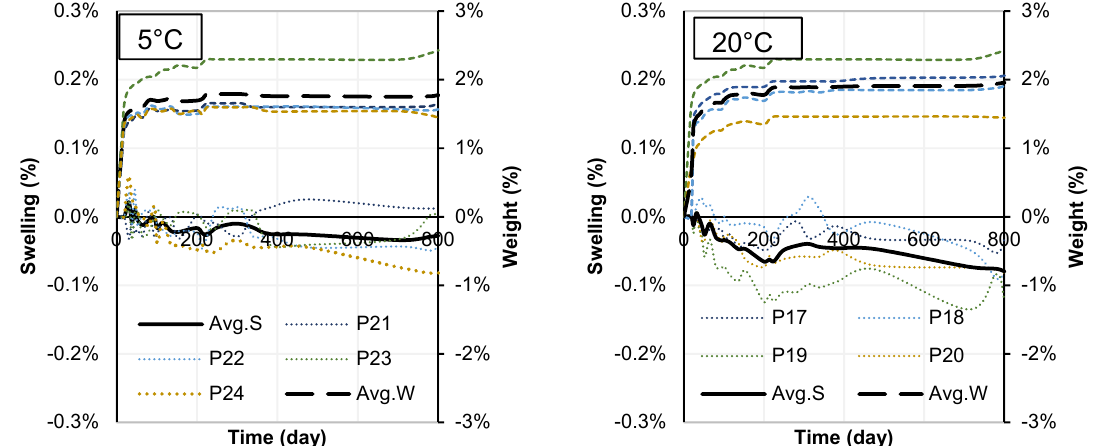
Figure A2. Swelling results in S + F + W3. The swelling and weight change in soil stabilized with cement and tap water are shown in Figure A3. The weight change in the sample at 20 °C was 1.23%, and the swelling/shrinkage in both temperatures are equal.